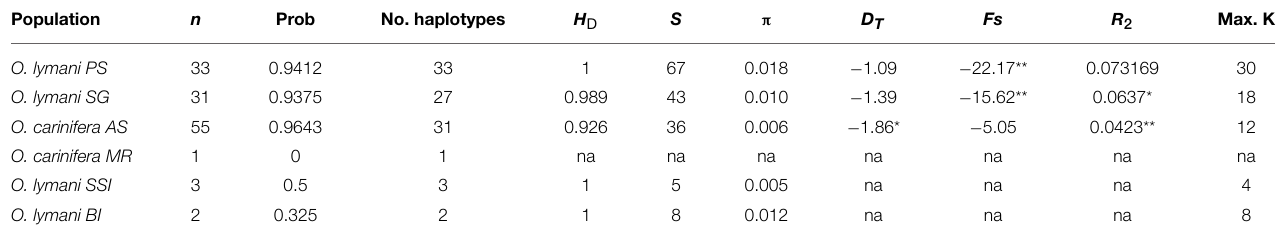
FIGURE 2 | Bayesian consensus phylogeny of partitioned CO1 sequences derived from Ophiura lymani from South Georgia shelf (red) Patagonian shelf (green), South Sandwich Islands (purple) and Bouvetoya (mustard). Ophiura carinifera samples are blue, Ophiura rouchi TABLE 1 | Summary statistics of molecular